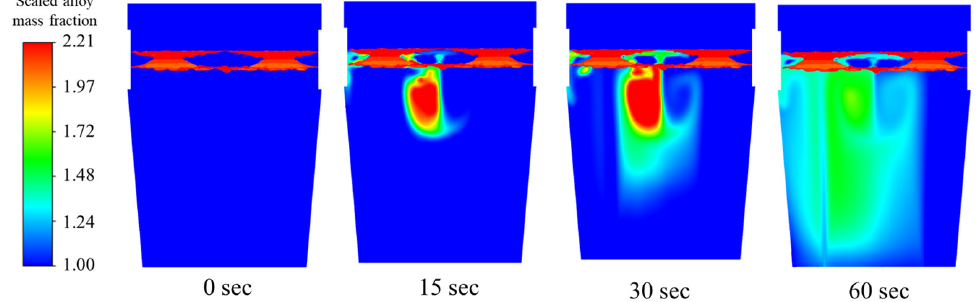
Figure 16. Mixing behavior of columbium alloy for 1.7 m 3 /min total flow rate.